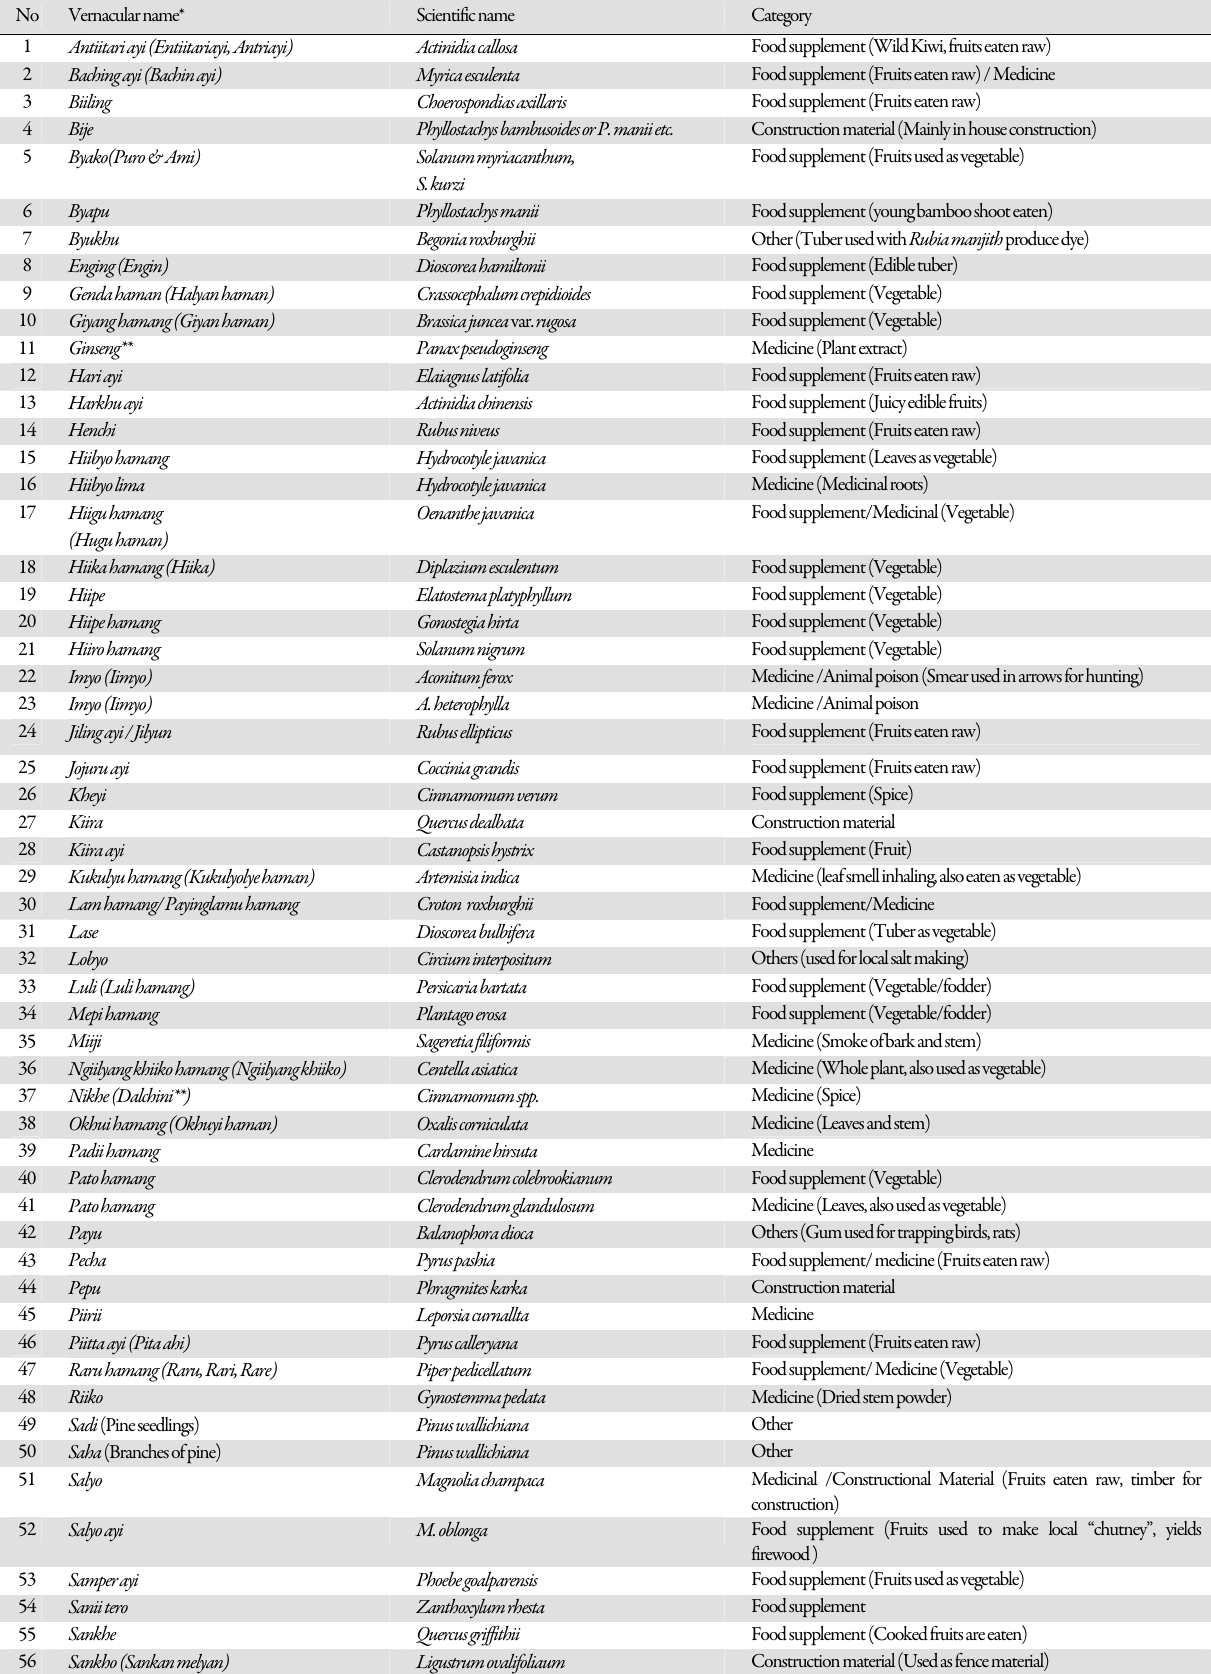
Table 1: Priority Non Timber Forest Products with vernacular and scientific names, and major use categories.